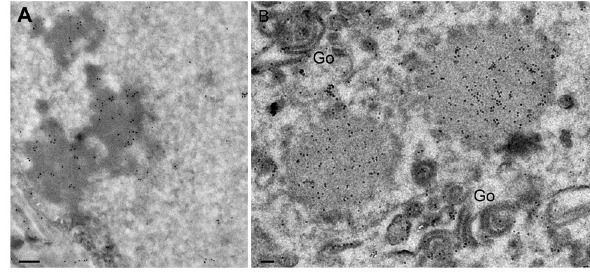
Figure 7. After infection with CK177 Δ Us3gK-HA, homogenous structures are intensely labeled by antibodies against HA in nuclei ( A ) and cytoplasm where they often neighboring Golgi membranes (Go). Bars, 200